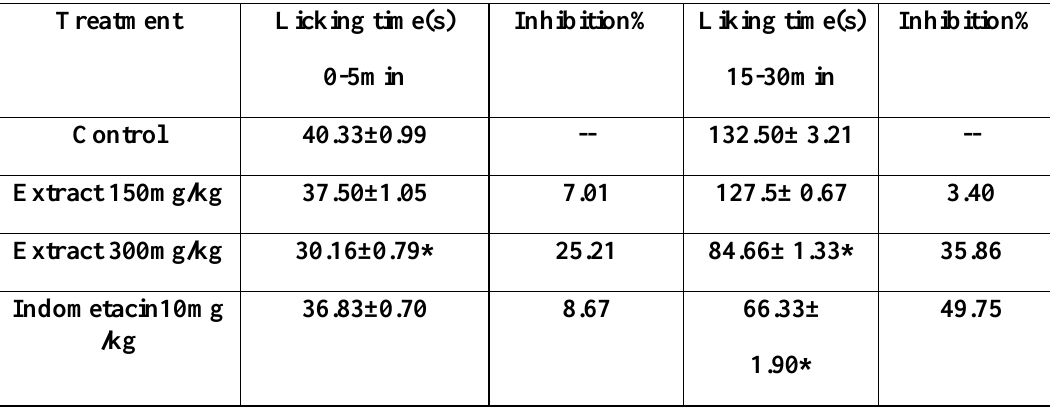
Values: M±SE Significantly different from control